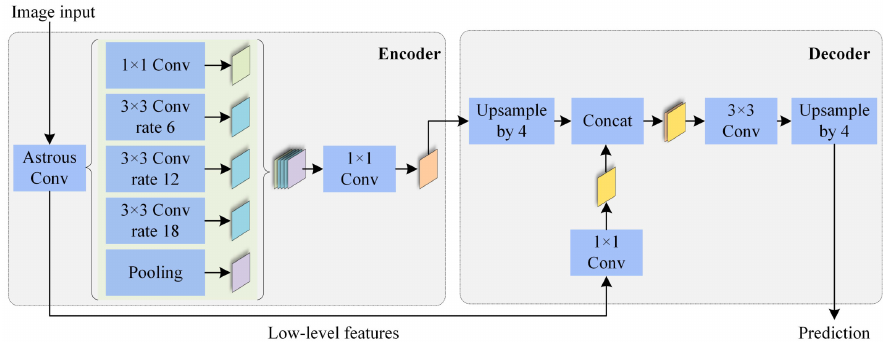
Figure 2. DeepLab v3+ uses an encoder–decoder architecture with two bilinear interpolation up- sampling in the decoder stage to recover the edge information of the